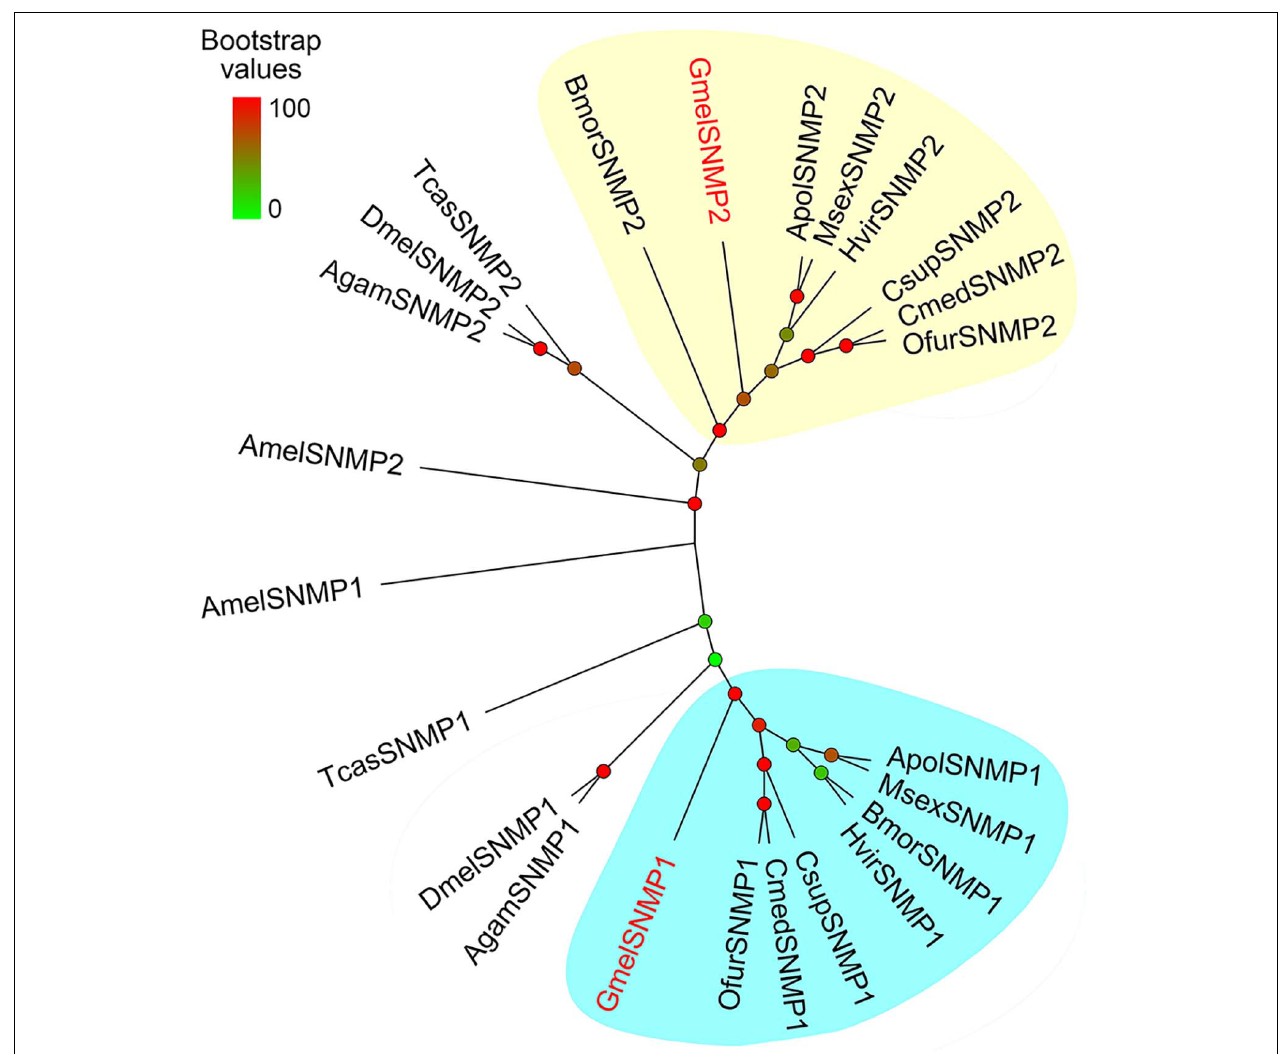
FIGURE 8 | Phylogenetic relationships of insect SNMPs. Gmel: Galleria mellonella ; Apol: Antheraea polyphemus ; Bmor: Bombyx mori ; Csup: Chilo suppressalis ; Cmed: Cnaphalocrocis medinalis ; Hvir: Heliothis virescens ; Msex: Manduca sexta ; Ofur: Ostrinia furnacalis ; Agam: Anopheles gambiae ; Amel: Apis mellifera ; Dmel: Drosophila melanogaster ; Tcas: Tribolium castaneum . Bootstrap values are indicated by colors from green (0) to red (100). The G. mellonella SNMPs are highlighted in red. GenBank accession numbers of genes used are listed in Supplementary Table 1 .